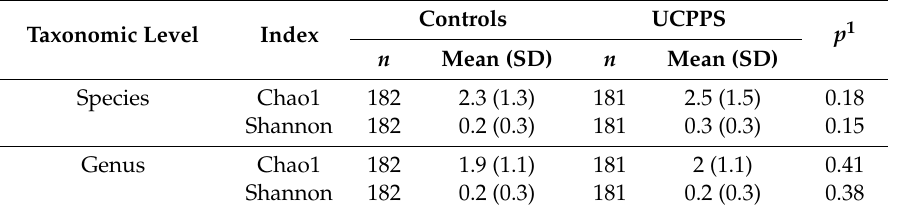
Table 4. Chao1 and Shannon’s index at the species and genus